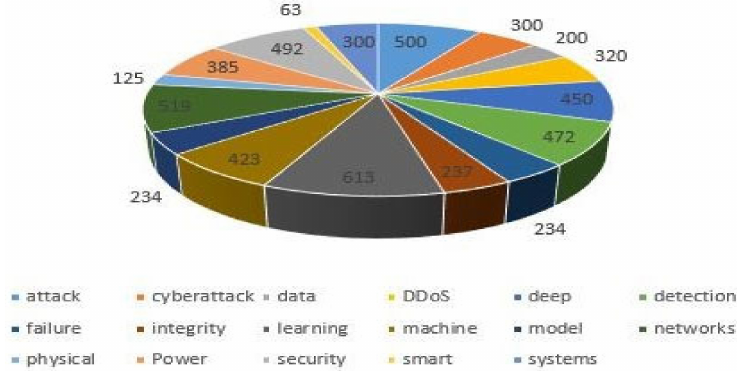
Figure 3. General topics in cybersecurity between 2019 to